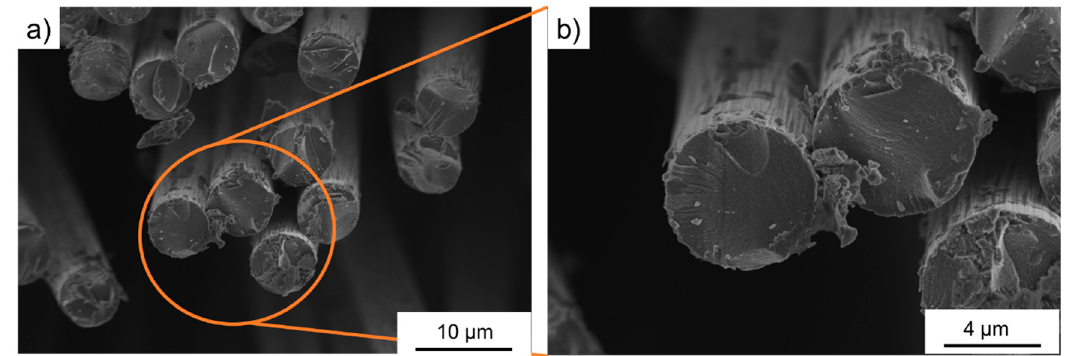
Figure 1. SEM cross-section images of the uncoated carbon fiber ( a ) overview picture, ( b ) marked section magnified.